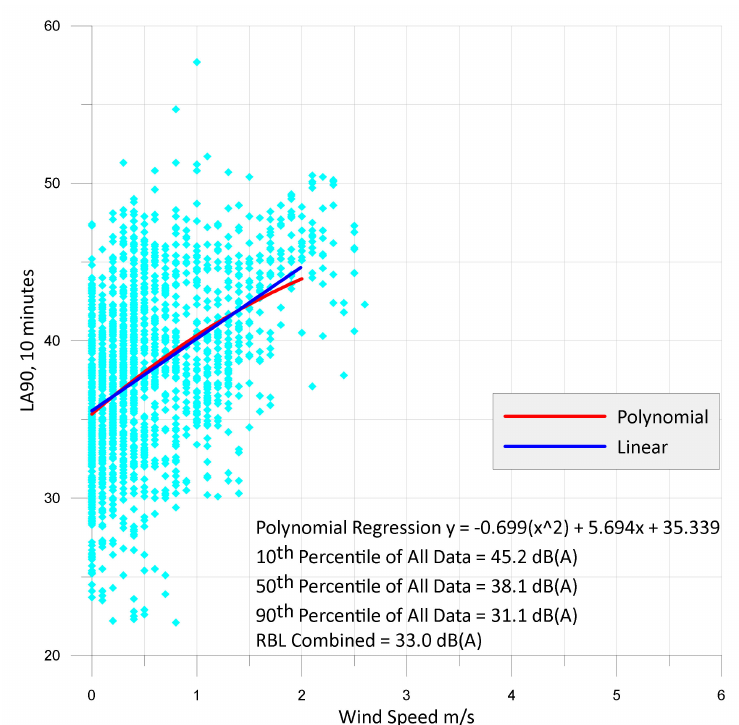
Figure 14. Waubra Wind Farm Regression for NE Wind Quadrant—Post Construction Test, Microphone and wind at 1.5 m AGL.